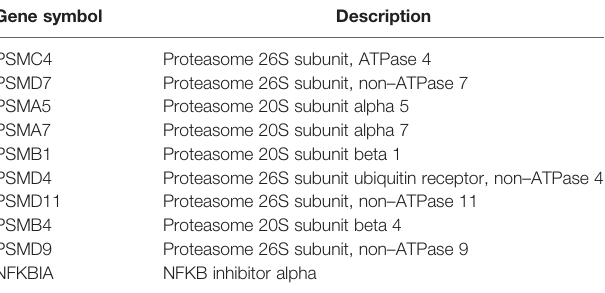
TABLE 2 | Top 10 hub genes identi fi ed by fi ve algorithms of cytoHubba. Gene symbol